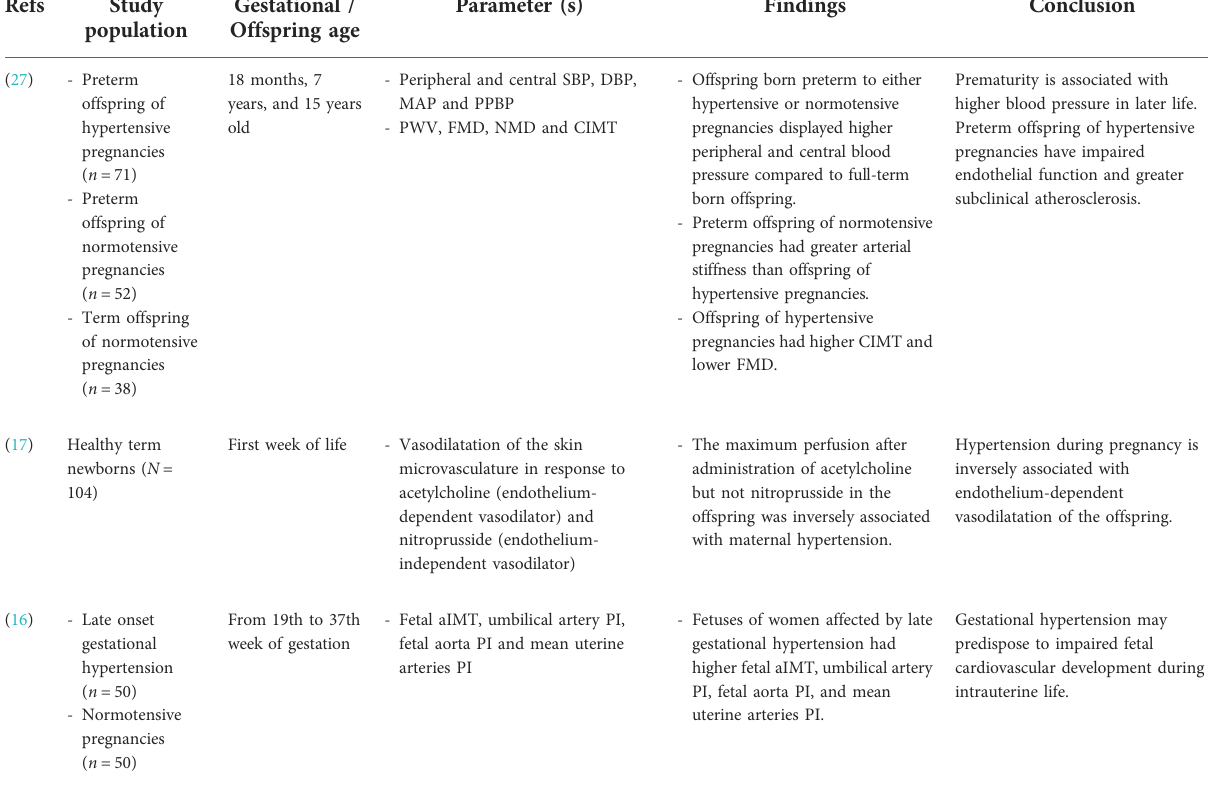
TABLE 1 Summary of the impact of de novo HDP on offspring vasodilation and subclinical